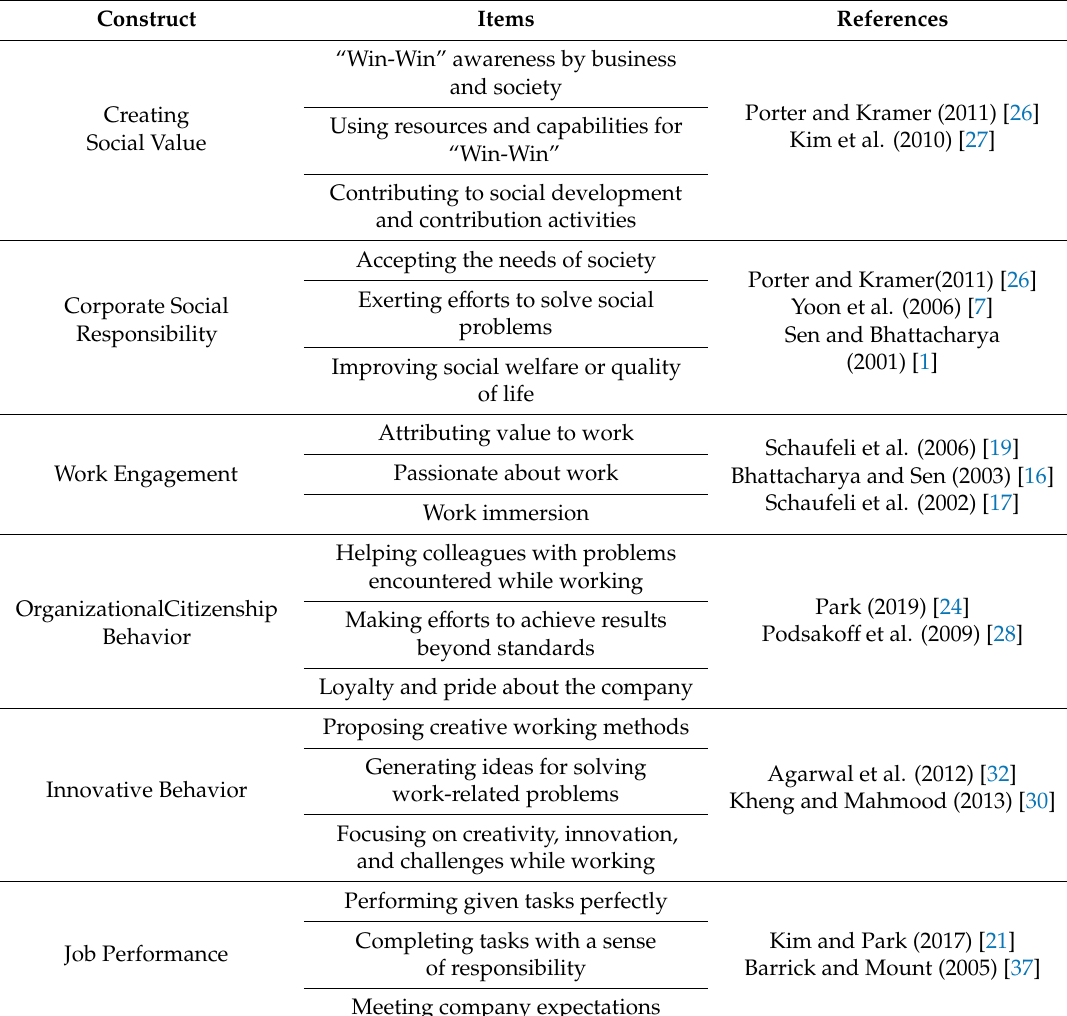
Table 1. Research constructs and operationalization.